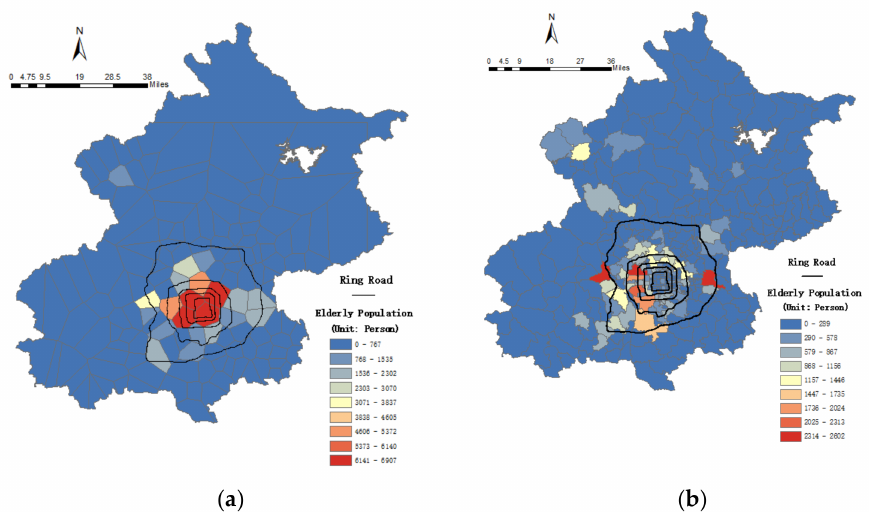
Figure 7. Home location detection distribution of the elderly cardholders in ( a ) 147-polygon Voronoi diagram and ( b ) 328